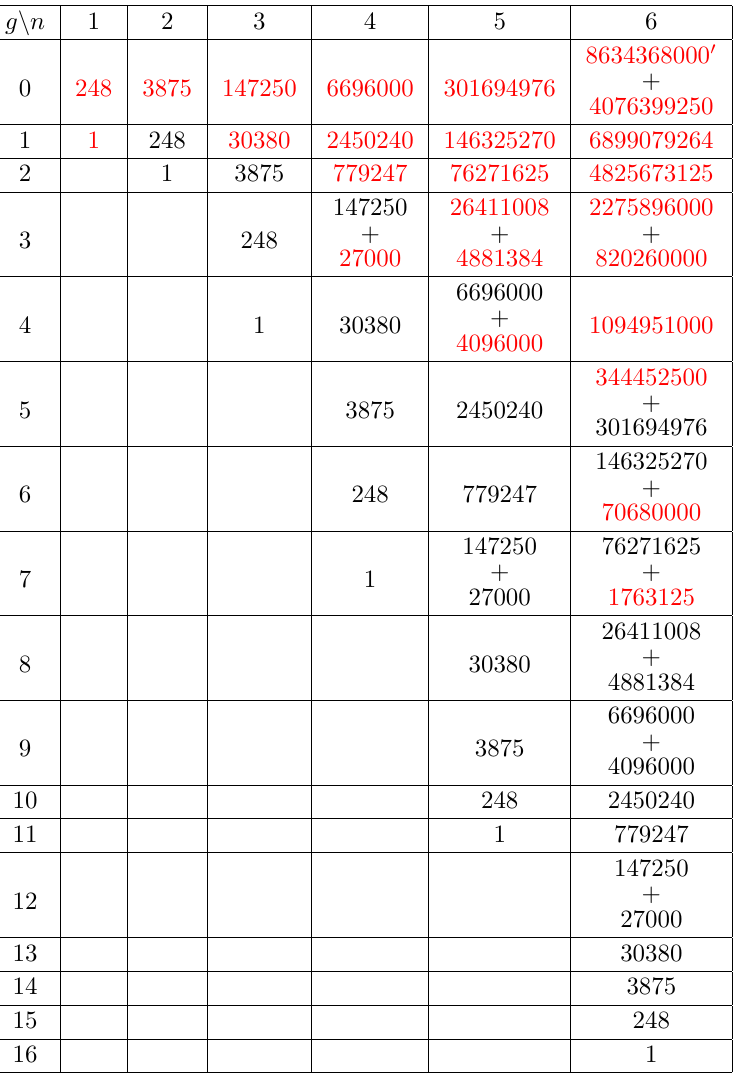
Table 6 . We report a di(cid:11)erent way of looking of the allowed representation for BPS states of the E 8 theory with asymptotic charges n (1 ; 0). The representation is indicated in red when it occurs for the (cid:12)rst